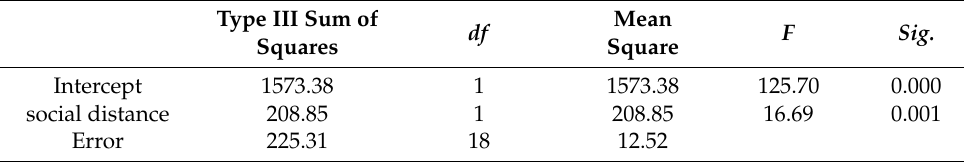
Figure 4. N1, P2 amplitudes of different social distance groups (prevention focus group). Table 9. Tests of Between-Subjects Effects of N1 amplitude (prevention focus).